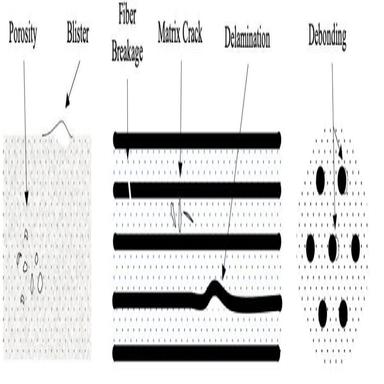
Various types of damages in multi-layer composite materials.